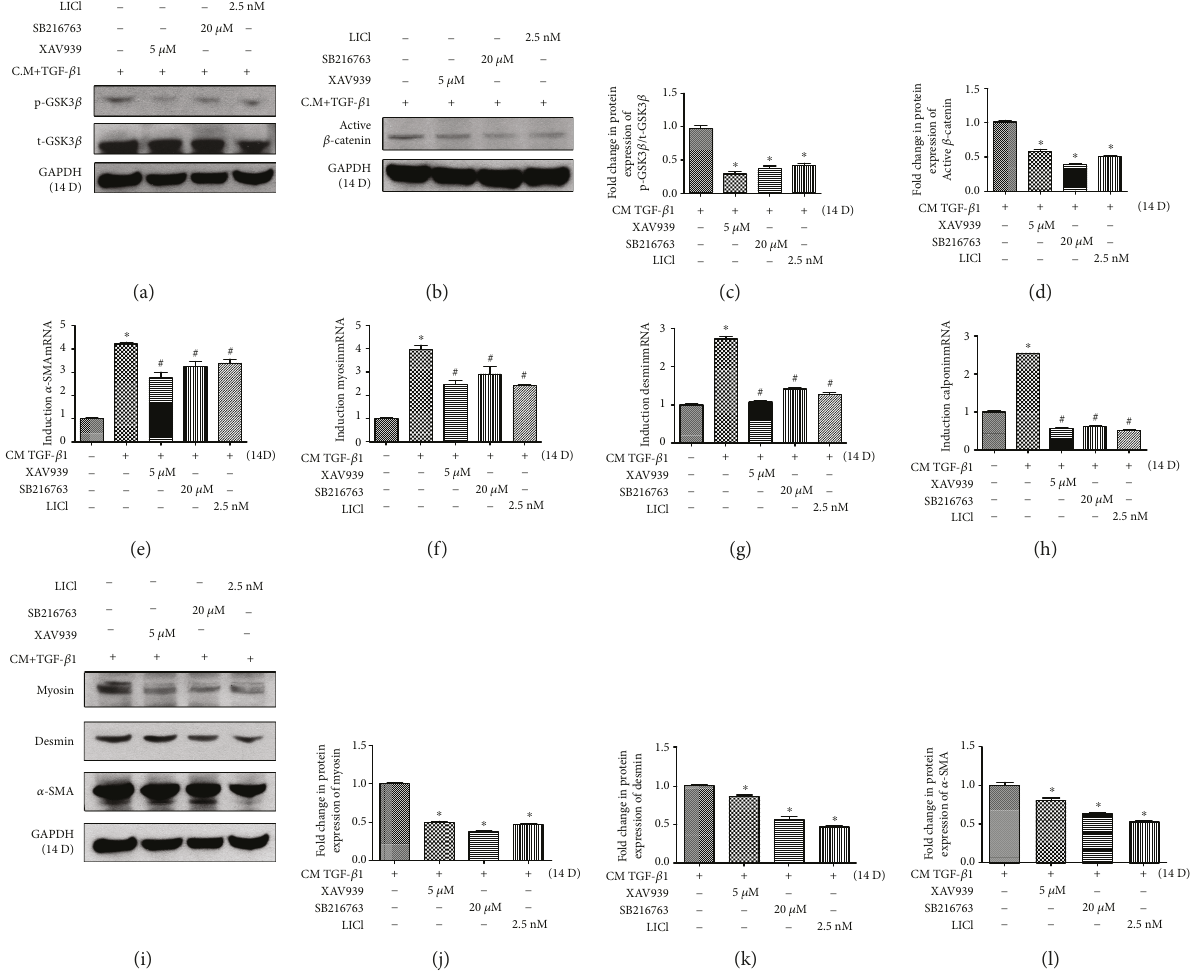
Figure 4: Inhibition of Wnt-GSK3 β / β -catenin prohibits the SMC di ff erentiation from DPSC clone A32. The A32 clone was induced following the SMC induction protocol with or without the Wnt/ β -catenin-speci fi c pharmacological inhibitor, XAV939, as well as the GSK3 inhibitors, SB216763 and LiCl, for 14d. The mRNA expression of α -SMA, myosin, desmin, and calponin were analysed with qPCR (e – h); the protein levels of p-GSK3 β , t-GSK3 β , active β -catenin, α -SMA, myosin, and desmin were analysed with western blotting (a, b, and i). The relative band intensities were determined by densitometry (c, d, and j – l). Statistical analysis was performed by using one-way ANOVA. Date are shown as means ± SEM . ∗ P < 0 05 when compared with the control